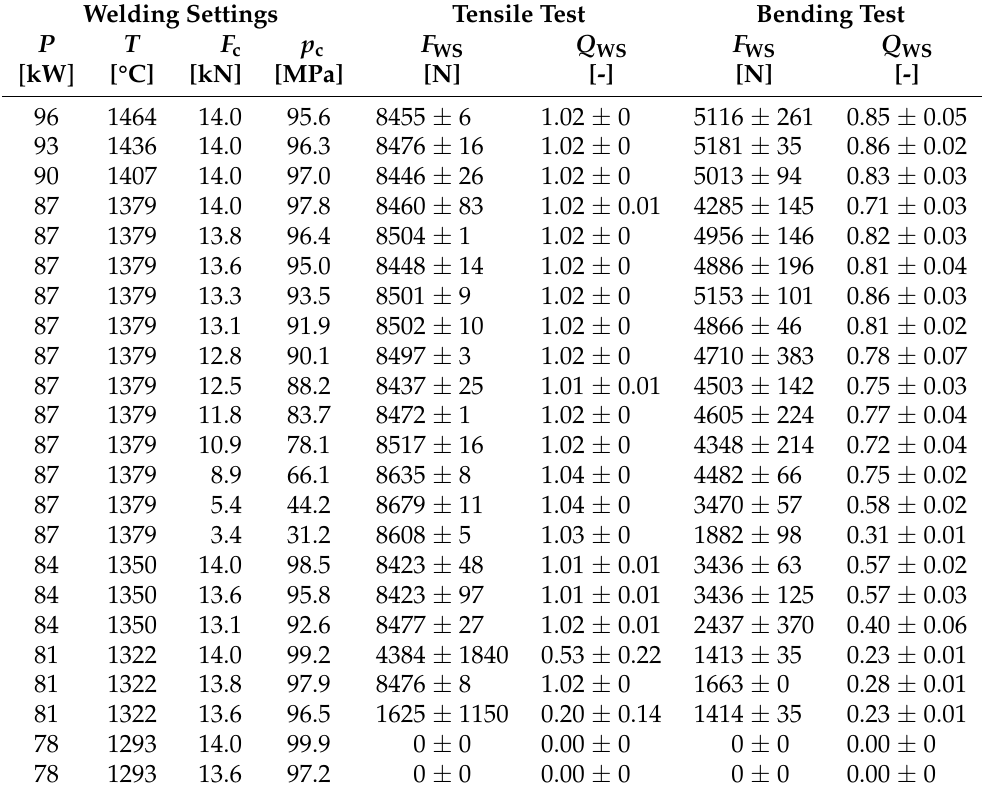
Table 6. Power P , temperature T , upsetting force F c , contact normal stress p c , fracture force F WS and weld seam strength ratio Q WS of the tensile test with as-welded specimens and the bending test with hardened specimens of the different welding